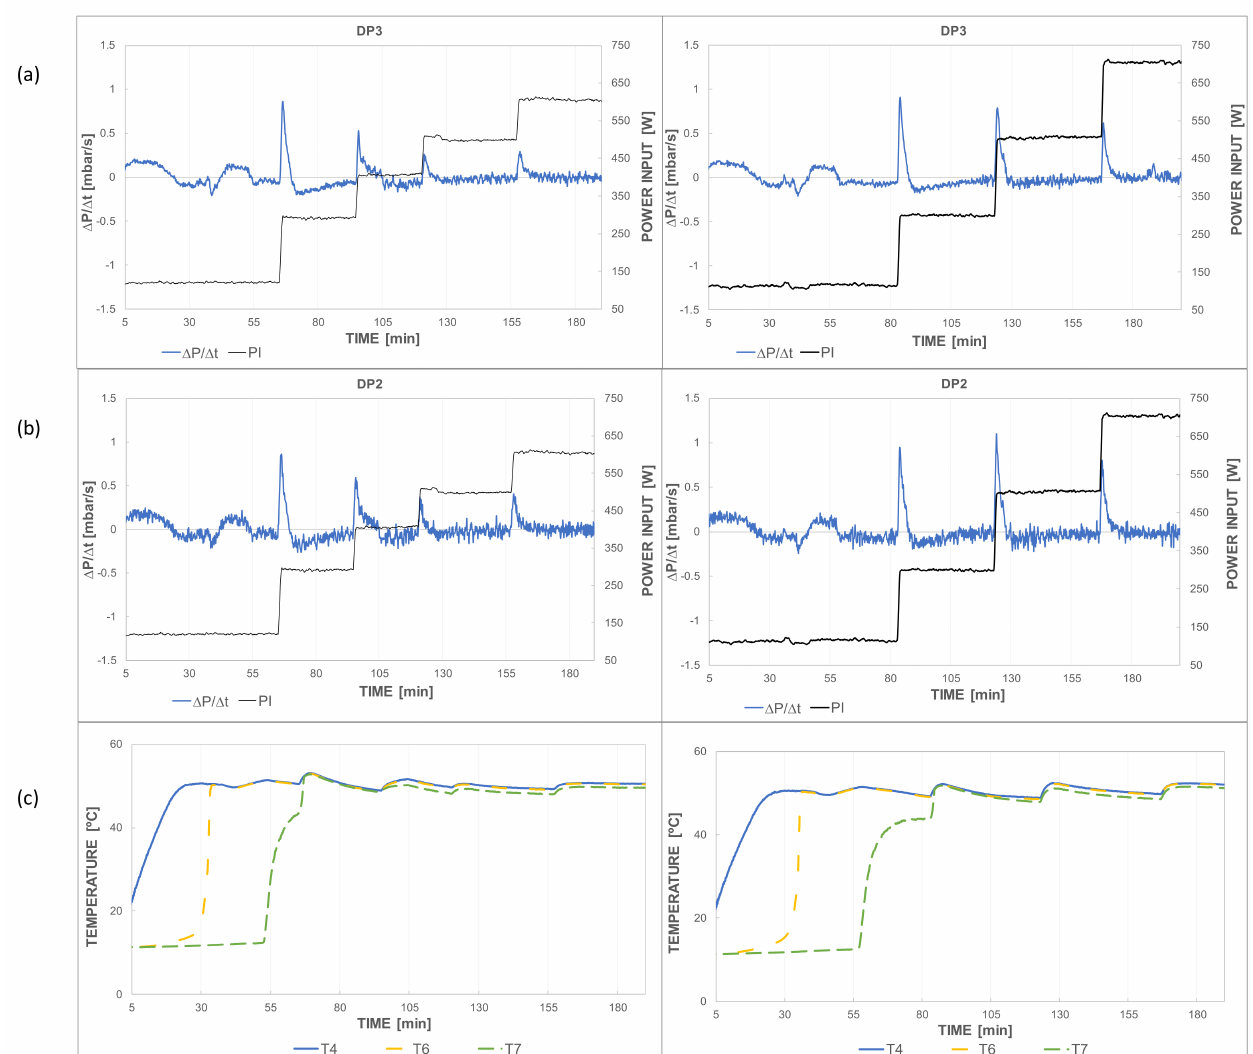
Figure 6. Pressure variation evolution for diverse power input increments. ( a ) Pressure change of the sensor DP3. ( b ) Pressure change of DP2. ( c ) Evolution of temperatures in the evaporator (T4), the riser (T6) and the upper point